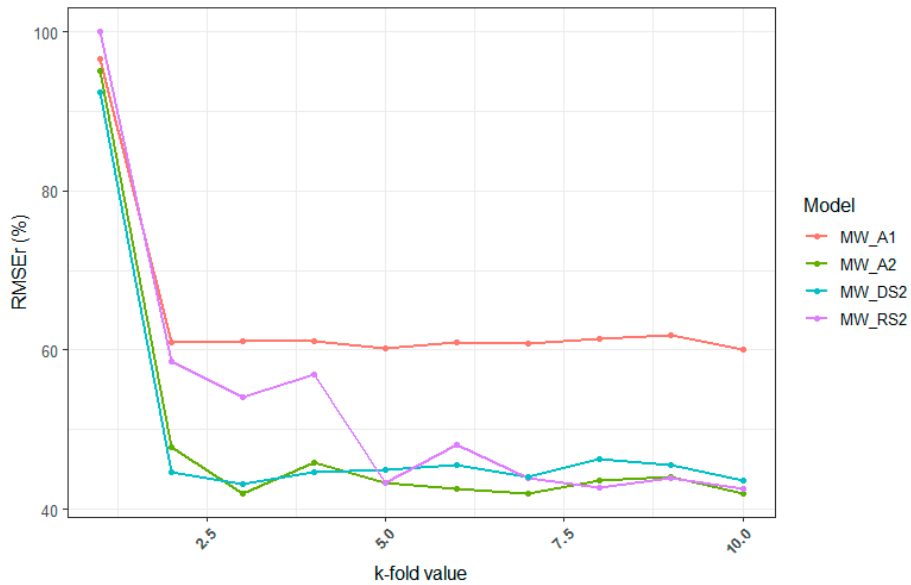
Figure 6. Sensitivity of the RMSEr values to different k-fold values for the MW based models.